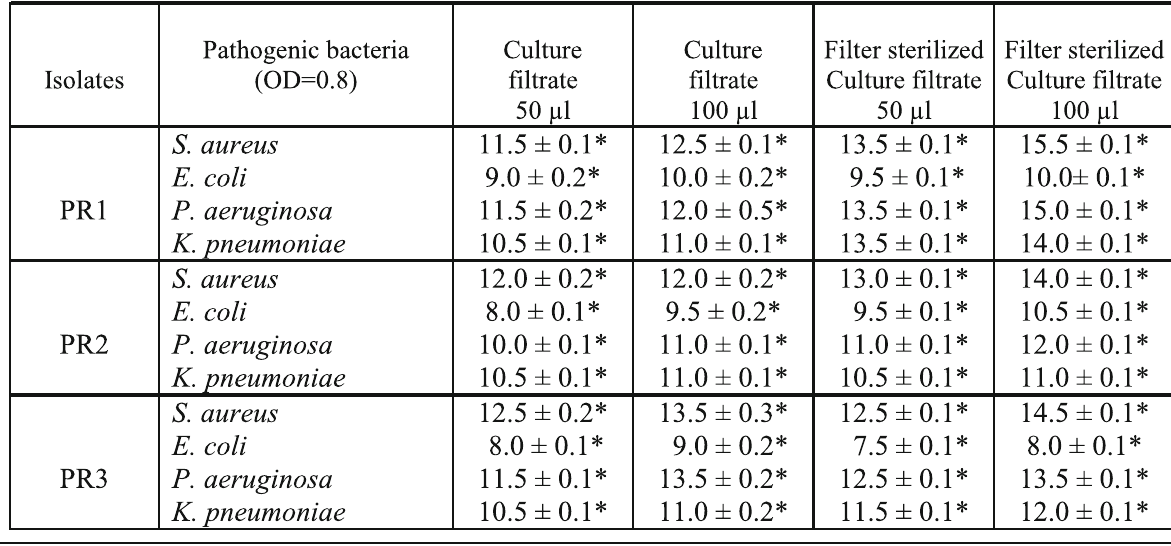
Table 3 Antibacterial activity of culture filtrate of PR1, PR2, and PR3 against pathogenic bacteria